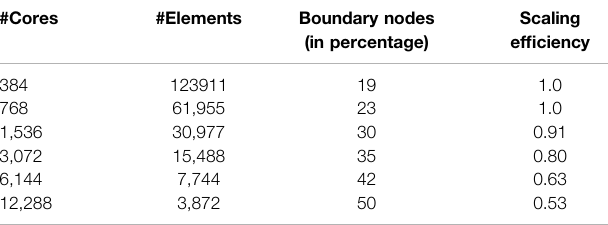
TABLE 3 | Partitioning statistics for test case 3 in Table 2. The second column reports the average number of elements per core. The third column reports the average percentage of nodes lying on inter-processor